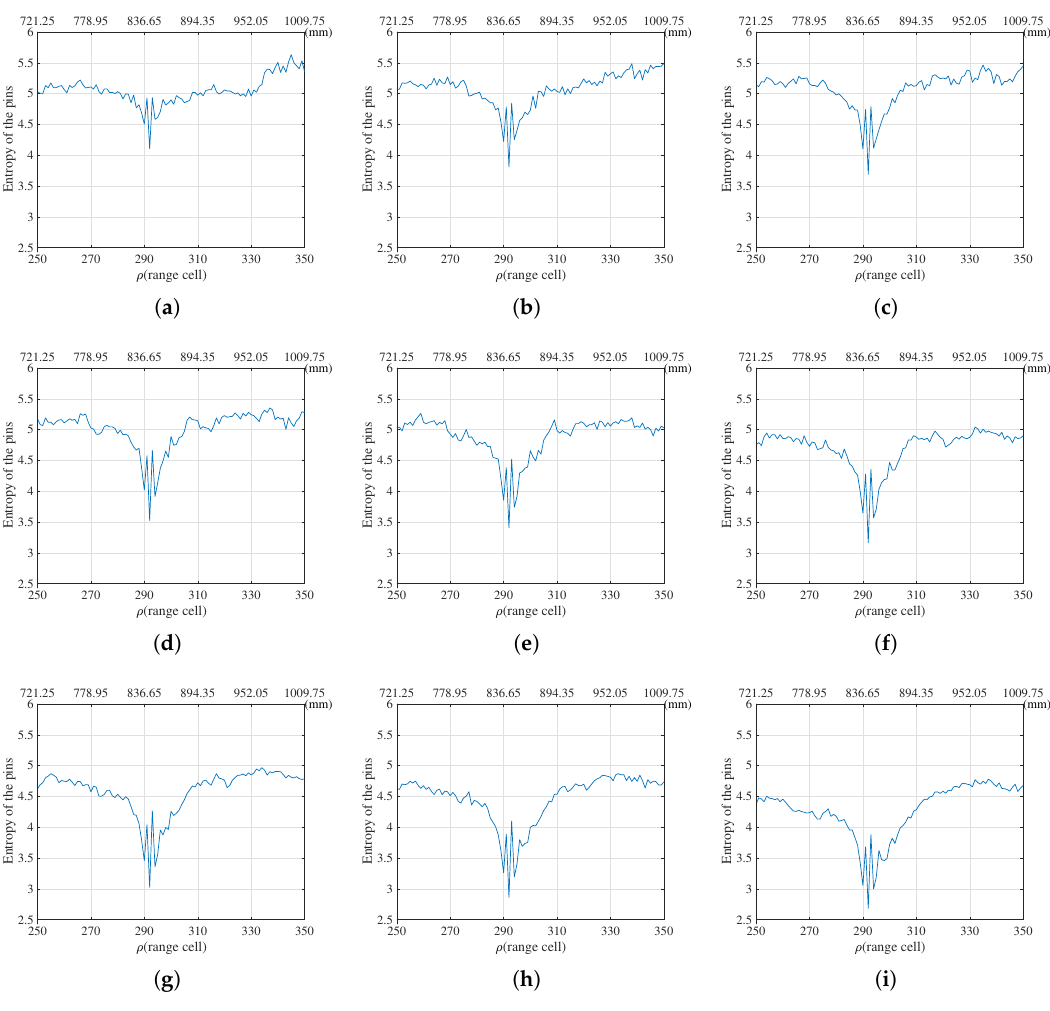
Figure 12. The entropies of the pin images reconstructed using a number of angles: ( a ) 36; ( b ) 72; ( c ) 108; ( d ) 144; ( e ) 180; ( f ) 216; ( g ) 252; ( h ) 288; ( i ) 324.